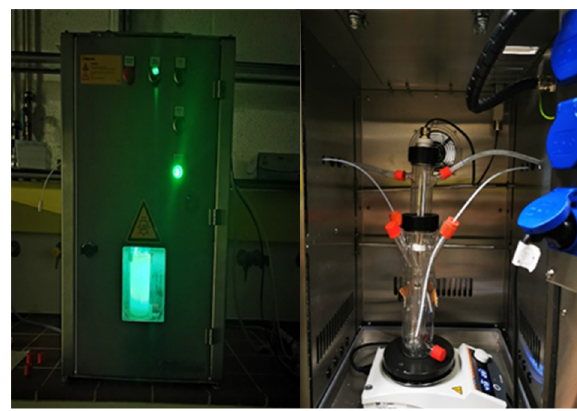
Figure 1. Photocatalytic reactor setup.